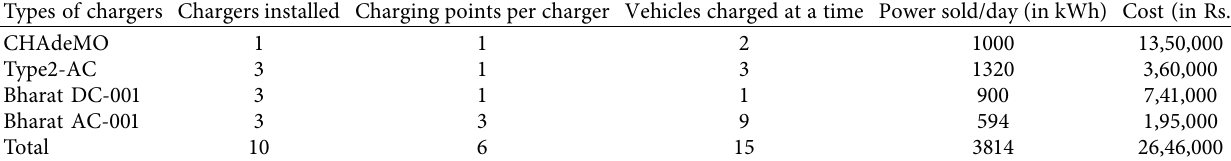
Table 8: Commercial medium charging station [131].